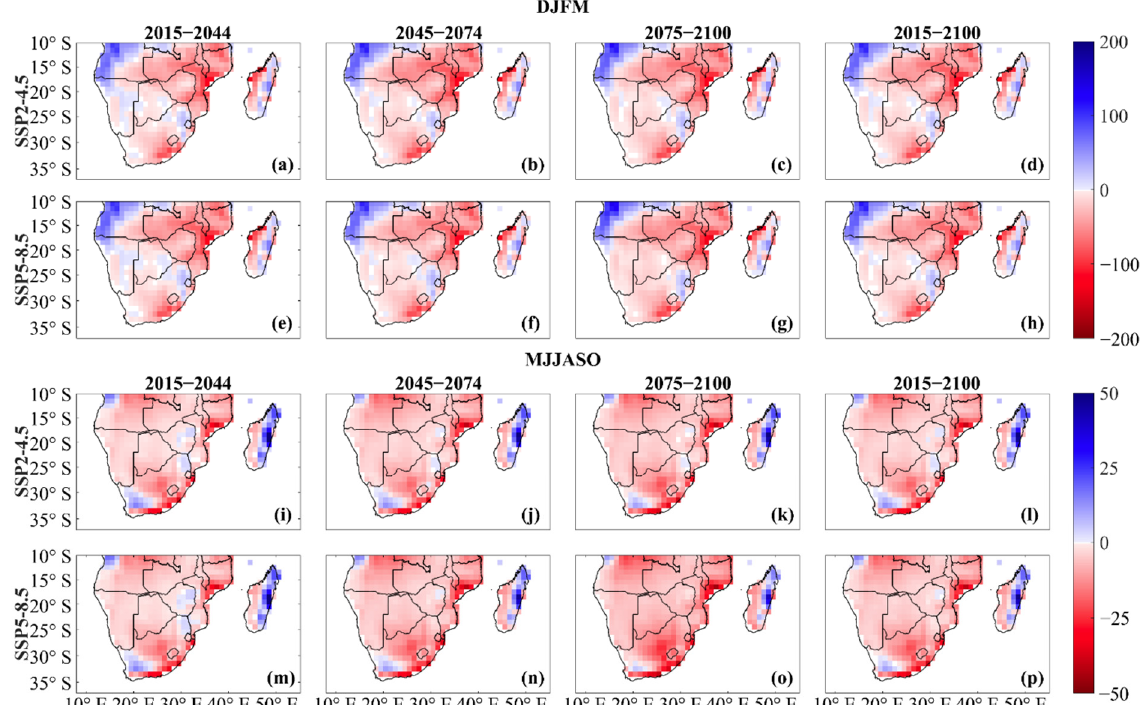
Figure 8. Spatial distribution of projected seasonal precipitation difference (mm) over Southern Africa, under the SSP2-4.5 (first and third row) and SSP5-8.5 (second and fourth row) scenarios, during 2015–2044 (near future), 2045–2074 (mid-future), 2075–2100 (far future) and 2015–2100 (total time length). ( a – h ) DJFM and ( i – p ) MJJASO. The difference is calculated as projected minus baseline period.